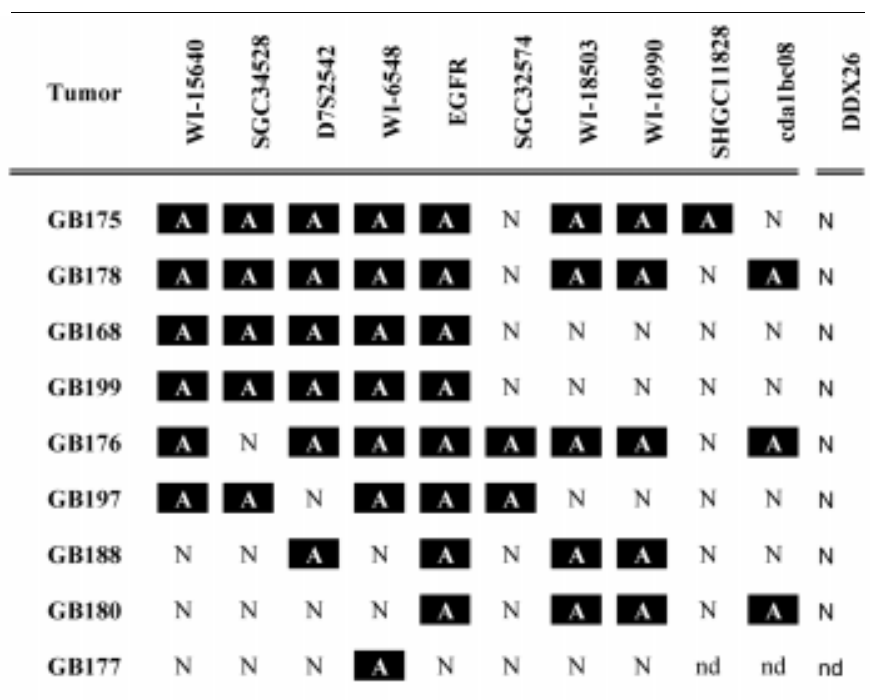
Table 1. Amplification of different markers located on chromosome 7p12 in glioblastoma